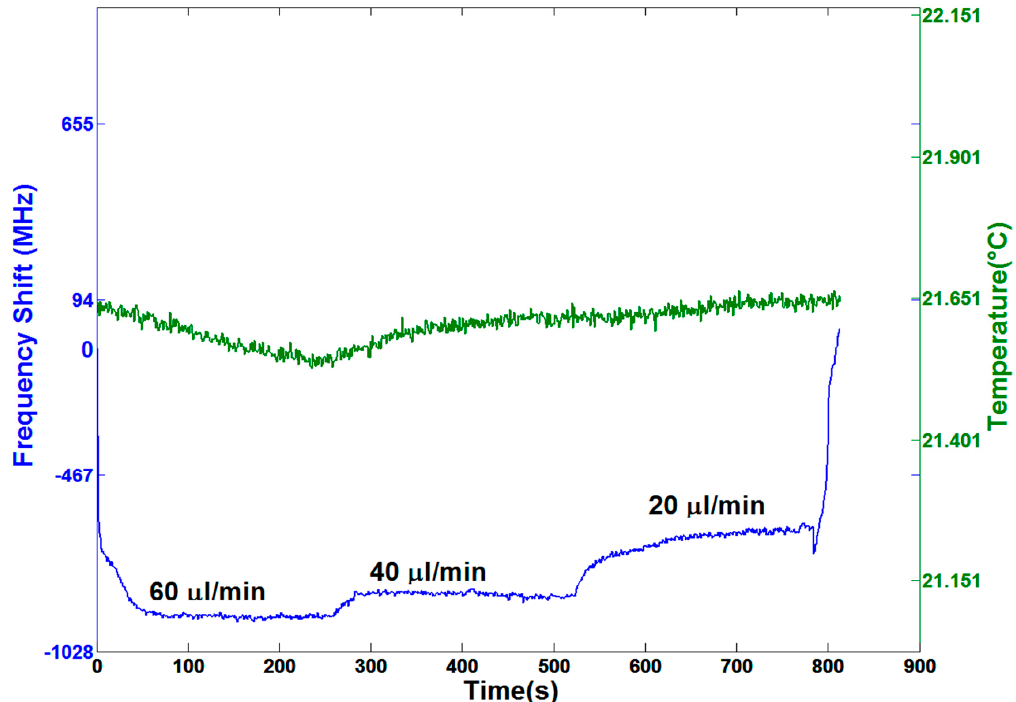
Figure 5. Resonance frequency shifts and temperature fluctuations versus elapsed time with water flowing at different pumping speeds starting with no flow and ranging from 60 µ L/min up to 20 µ L/min with steps of 20 µ L/min, as produced by a syringe pump. A different shift for each pumping speed is clearly observable. The correspondent fluctuation parameter σ is the same as the one with the pump switched off. In this case, the variations induced by thermal fluctuations are negligible.